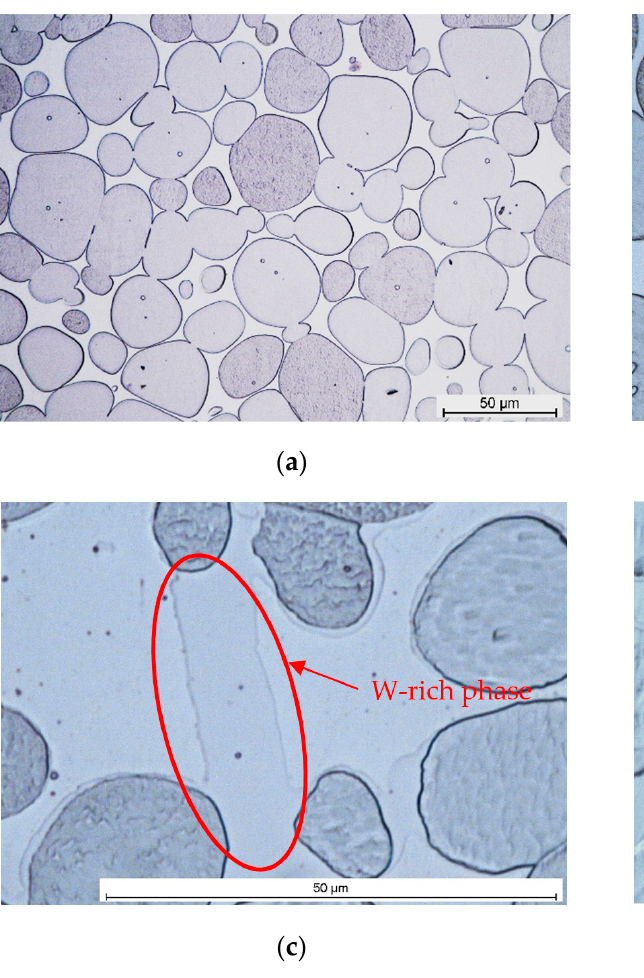
Figure 2. Microstructure of WHA samples: ( a , b ) WNi9Co1; ( c , d ) WNi5Co5.